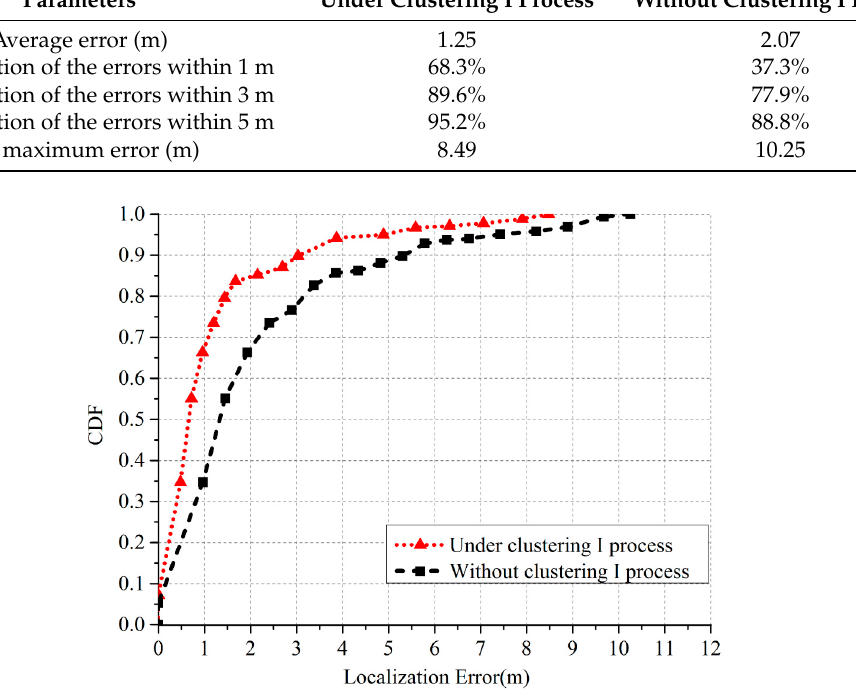
Figure 18. CDF of the localization errors under the Clustering I process and without the Clustering I process.